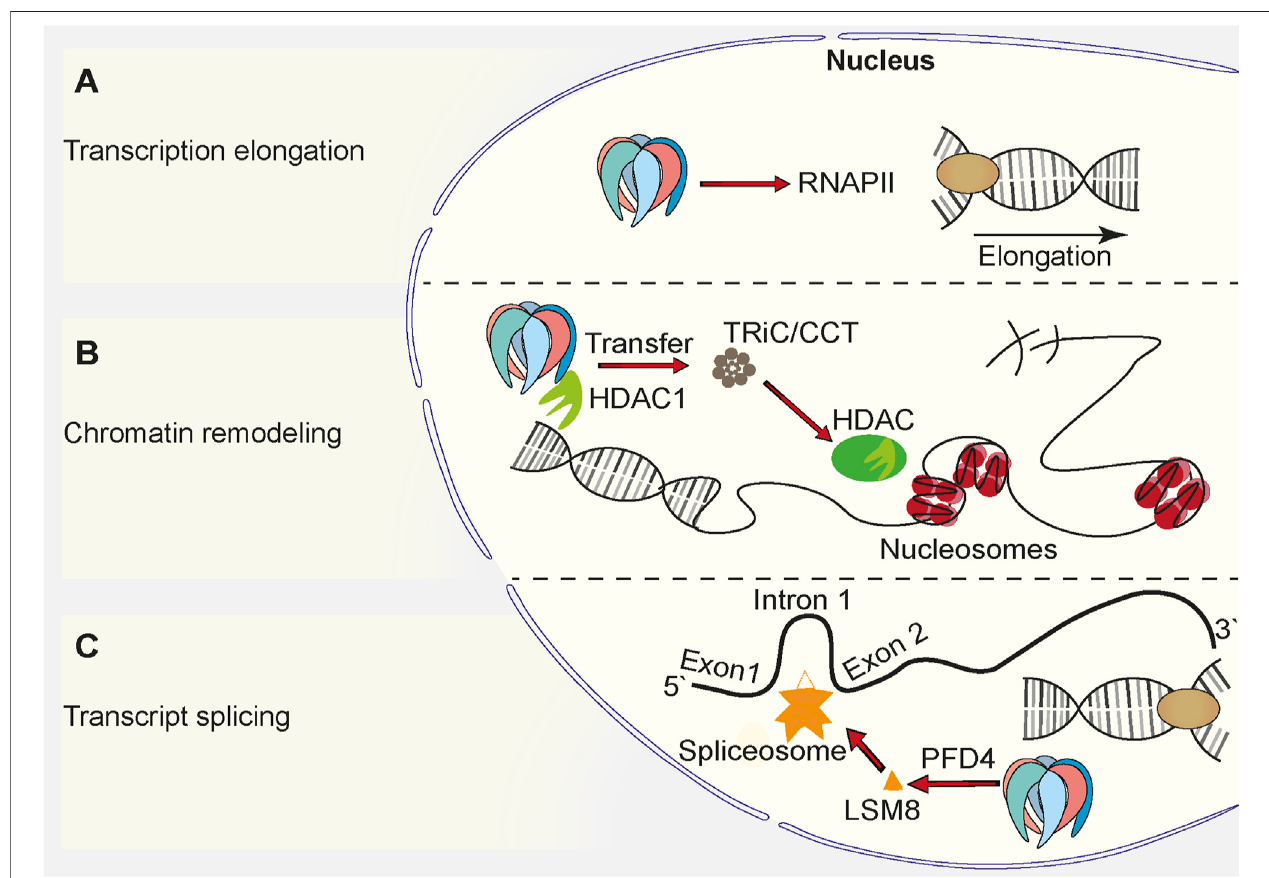
FIGURE 2 | Function of prefoldin complex in the cell nucleus. (A) Prefoldin stimulates transcription elongation by promoting binding of RNA Polymerase II (RNAPII) to euchromatin. (B) Prefoldin interacts with HDAC1 and supports incorporation of it into its active complex via TRiC/CCT complex. The interaction favors chromatin remodeling. (C) The PFD4 subunit is required for the incorporation of the spliceosome core complex subunit, LSM8, into the spliceosome.